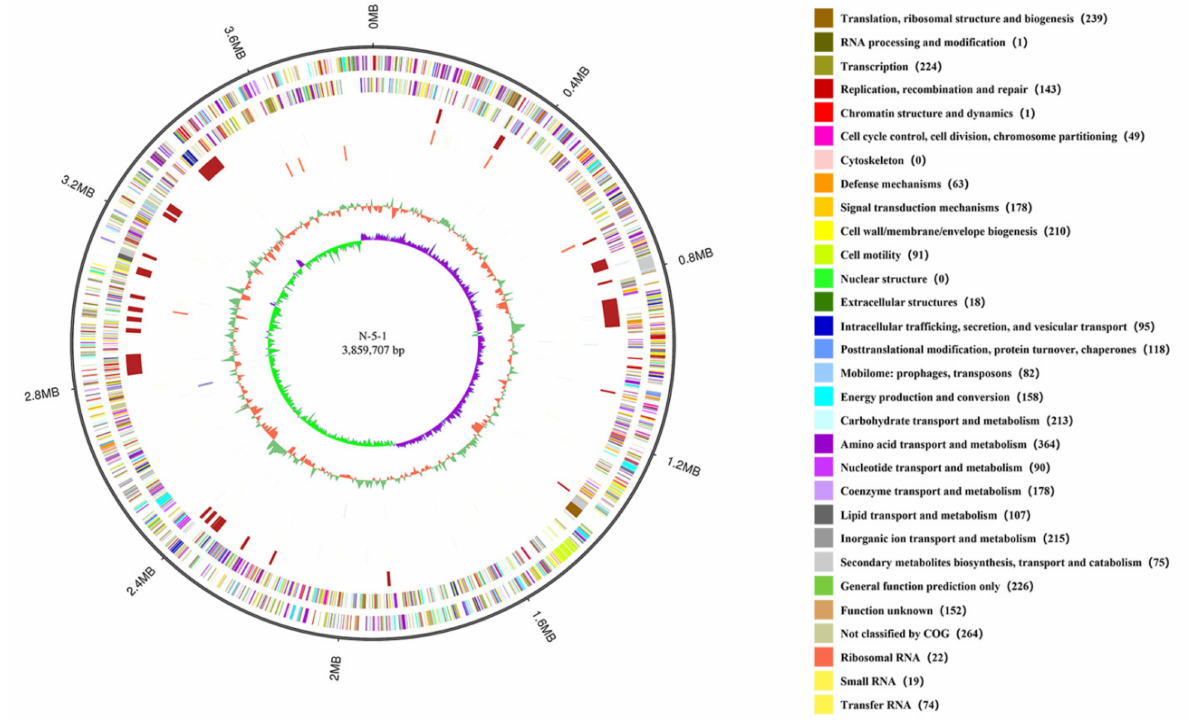
Figure 1. Genome organization of L. populi N-5-1. The outermost circle is the coordinate of the genome sequence position. From the outside to the inside, the first circle illustrates the clusters of orthologous groups (COG) annotation gene distribution of the positive strand, colored according to cluster; the second circle depicts the COG annotation of the negative strand; the third circle represents the distribution of the genomic islands by at least one method; the fourth circle denotes the ncRNA distribution of the forwarding strand; the fifth circle represents the ncRNA distribution of the reverse strand; the sixth circle describes the tandem repeat; the seventh circle depicts the GC content, in which the inward red section shows the area within the GC content below the genome-wide average GC content, and the outward green part shows, on the contrary, with the higher the peak of the representation, the greater the difference between the average GC content; the eighth circle denotes the GC skew (G-C/G + C); values >0 in green and values <0 in